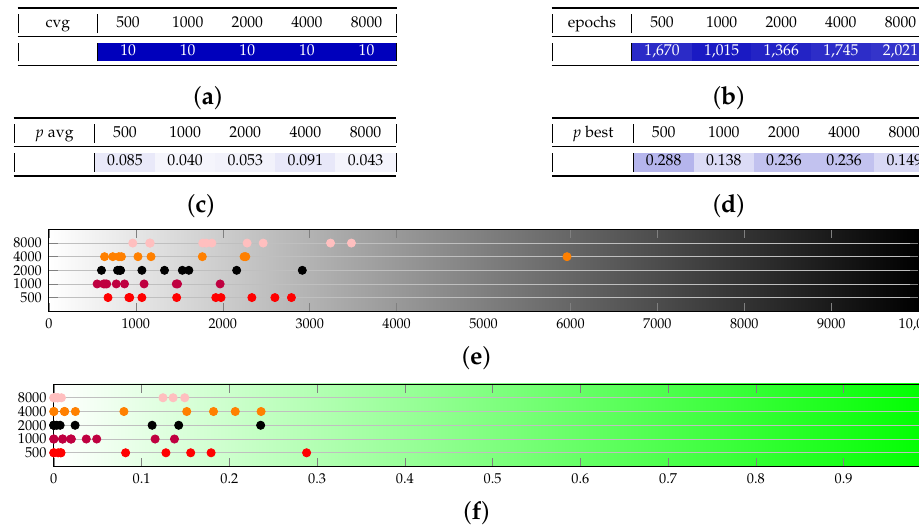
(b) Number of epochs before convergence, on average.